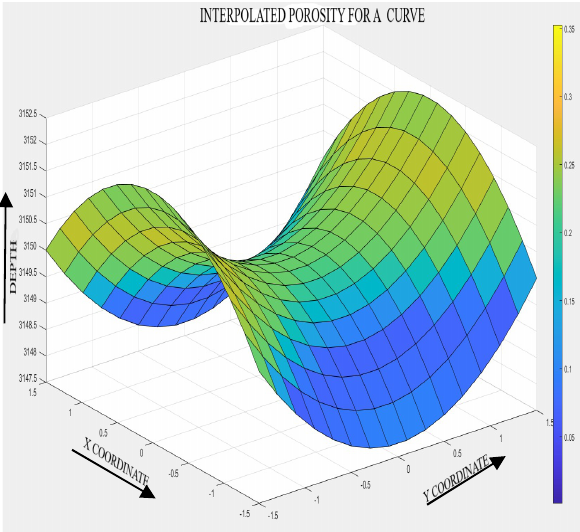
Figure 6. Section of the reservoir using a curved surface showing porosity (displayed on